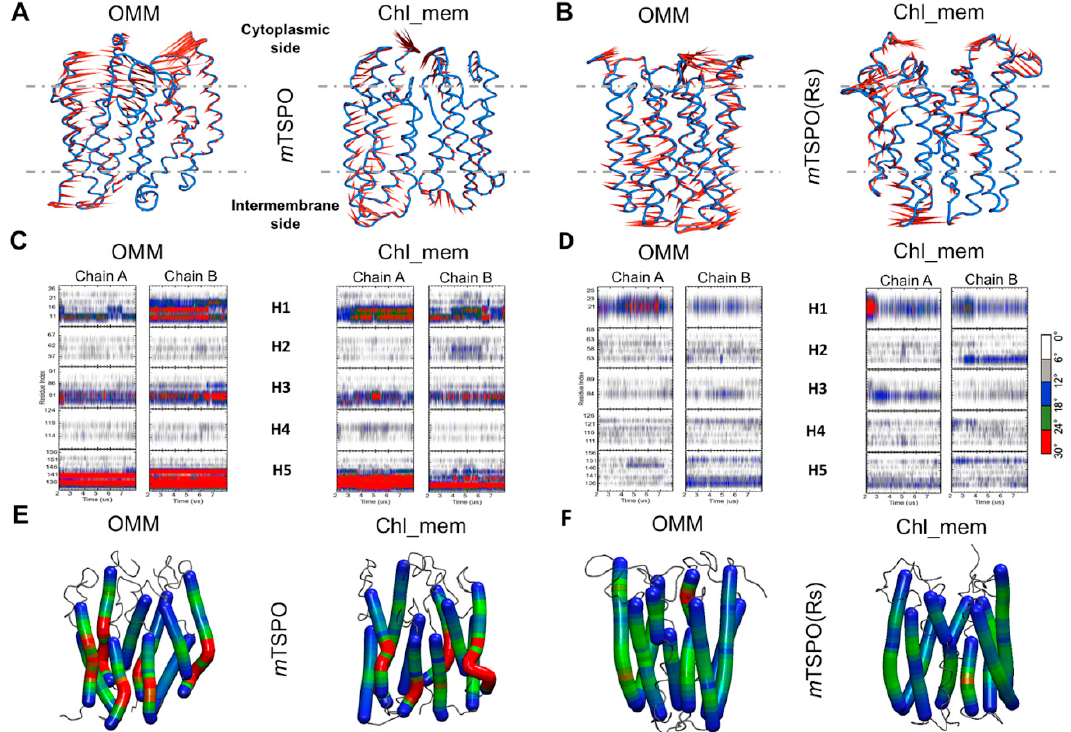
Figure 2. Porcupine plots depicting prominent motions averaged across the first normal mode for ( A ) m TSPO, ( B ) m TSPO(Rs) embedded in OMM and cholesterol rich membrane (chl_mem); the corresponding plots for the second normal mode are reported in Figure S4. A dotted line marks the approximate location of the membrane. The helix bending of ( C ) m TSPO, ( D ) m TSPO(Rs) in OMM and chl_mem is plotted as a function of the simulation time. The corresponding helix “hinge” regions are also shown on m TSPO ( E ) and m TSPO(Rs) ( F ) structures in OMM and chl_mem: the highly bent regions are highlighted in red color, while the least and moderately bent regions are highlighted in blue and green colors,